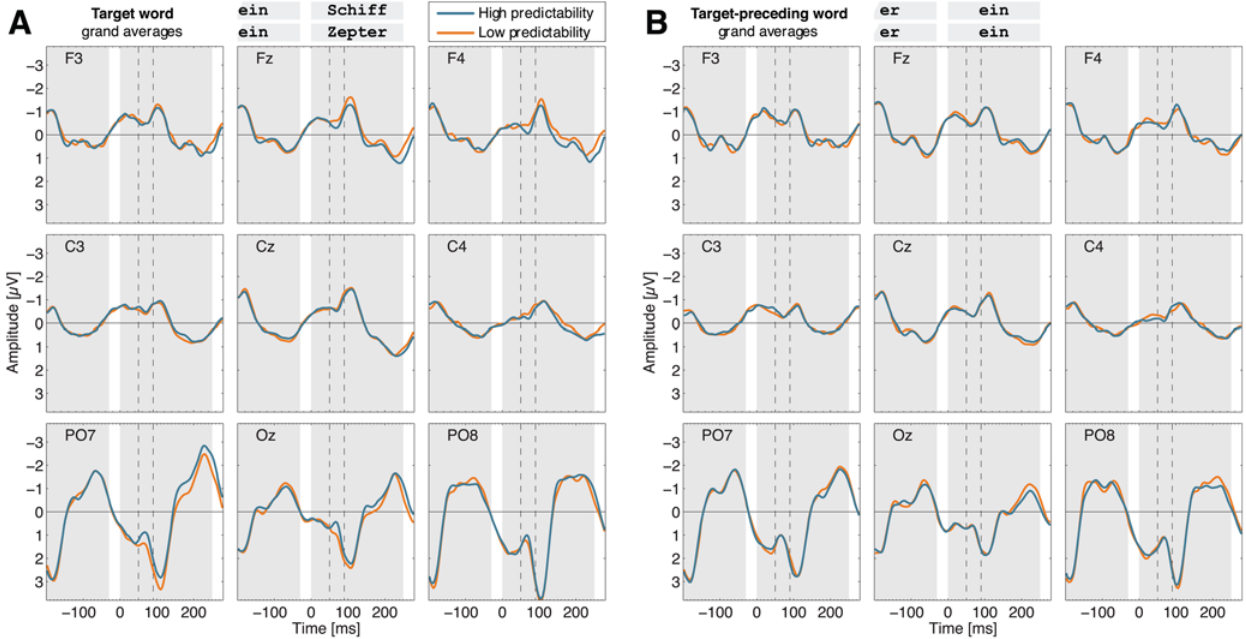
Figure 2. Grand averages for a sample of nine electrodes. ERPs for low (orange) and high predictability (blue) target conditions when (A) the target word or (B) the target-preceding word was presented. Background shading illustrates the stimulus sequence (gray: word present; white: blank screen). Dashed lines border the interval from 50 to 90 ms.